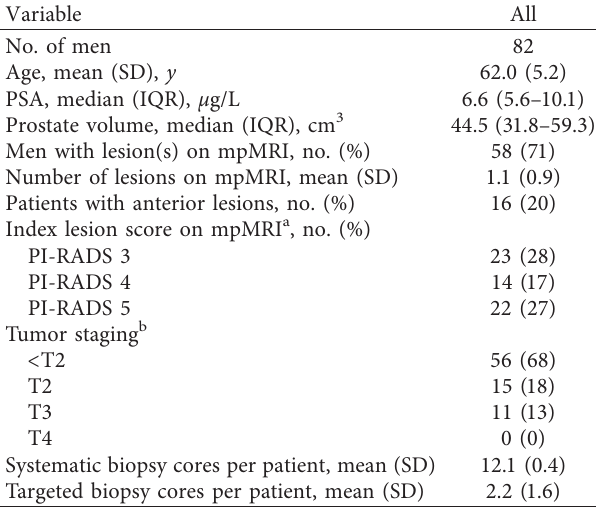
Figure 1: Flow Table 1: Patient demographics.